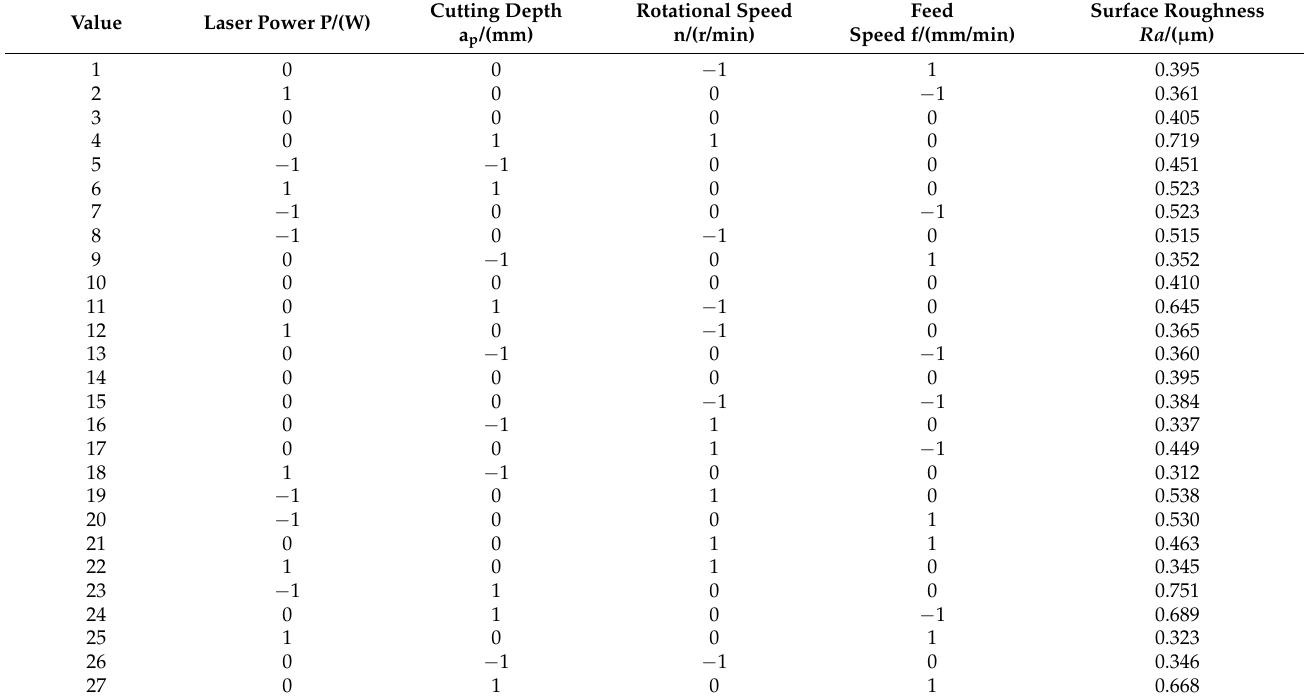
Table 7. BBD experimental results.